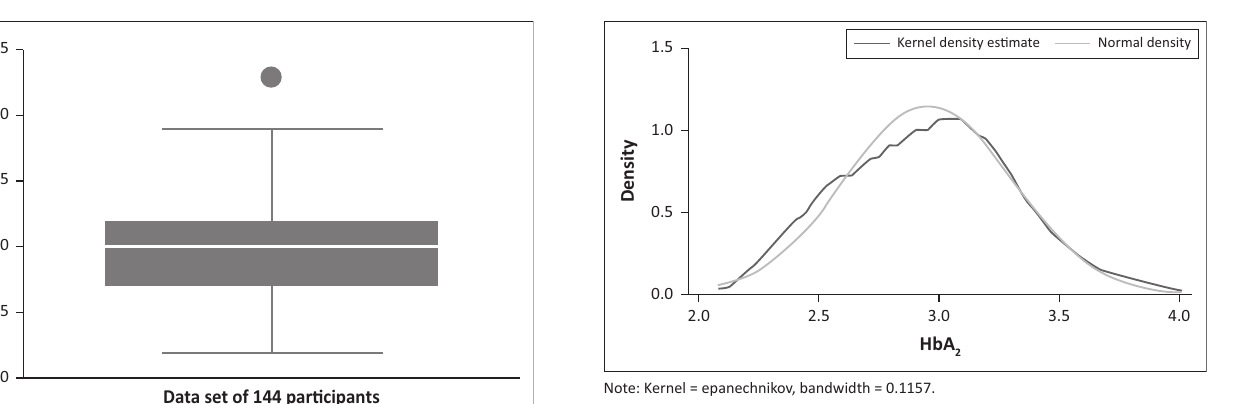
and age distribution, Pretoria, South 2